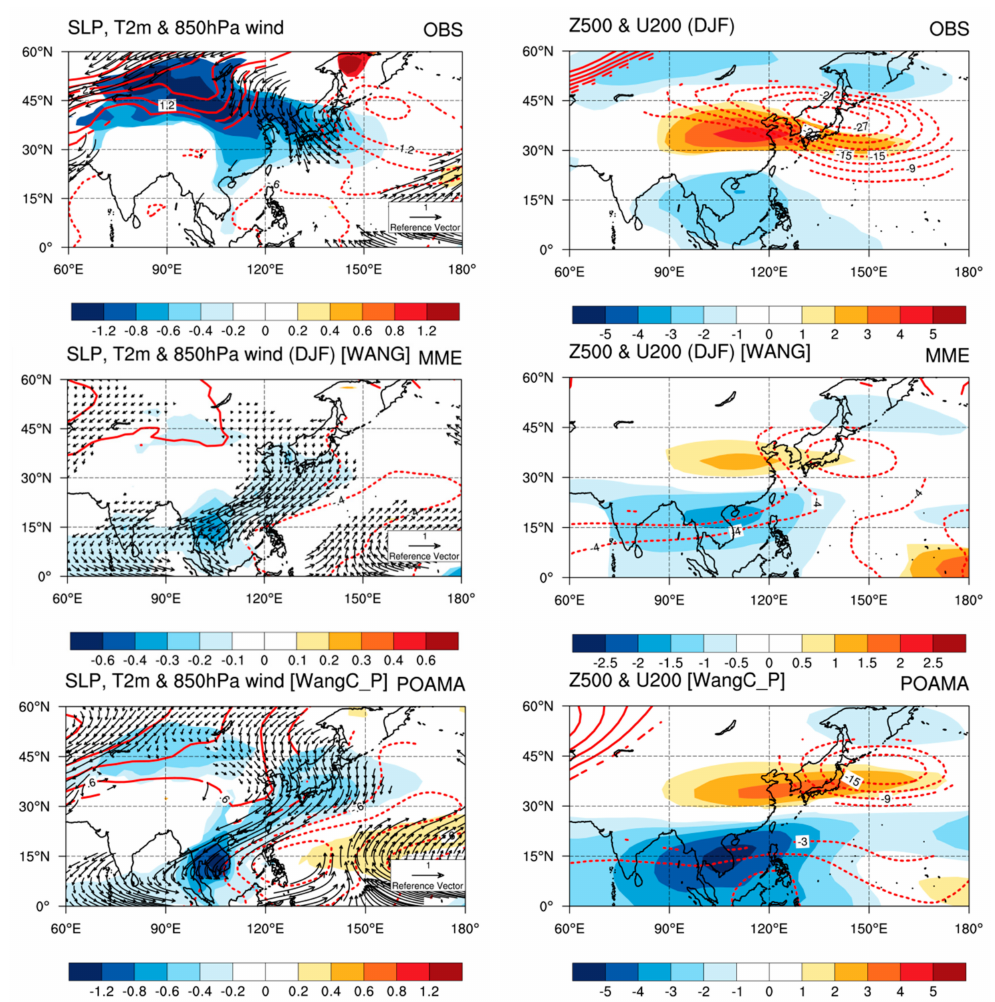
Figure 9. Regression onto the normalized EAWM index defined by Wang and Chen (2014) in the NCEP-R2 dataset of the DJF mean (left panels) sea level pressure (SLP, contours, hPa), surface air temperature (T2m, shading, ◦ C) and 850 hPa winds (vectors, m s − 1 ) (right panels) 500 hPa geopotential height (Z500, contours, gpm) and 200 hPa zonal wind (U200, shading, m s − 1 ). The upper panels are for the observations based on NCEP-R2 (OBS) and the middle and bottom panels are for the MME and POAMA results, respectively. Only values exceeding the 95% confidence level are shown. Note that the shading and contours in MME are different to those in OBS and